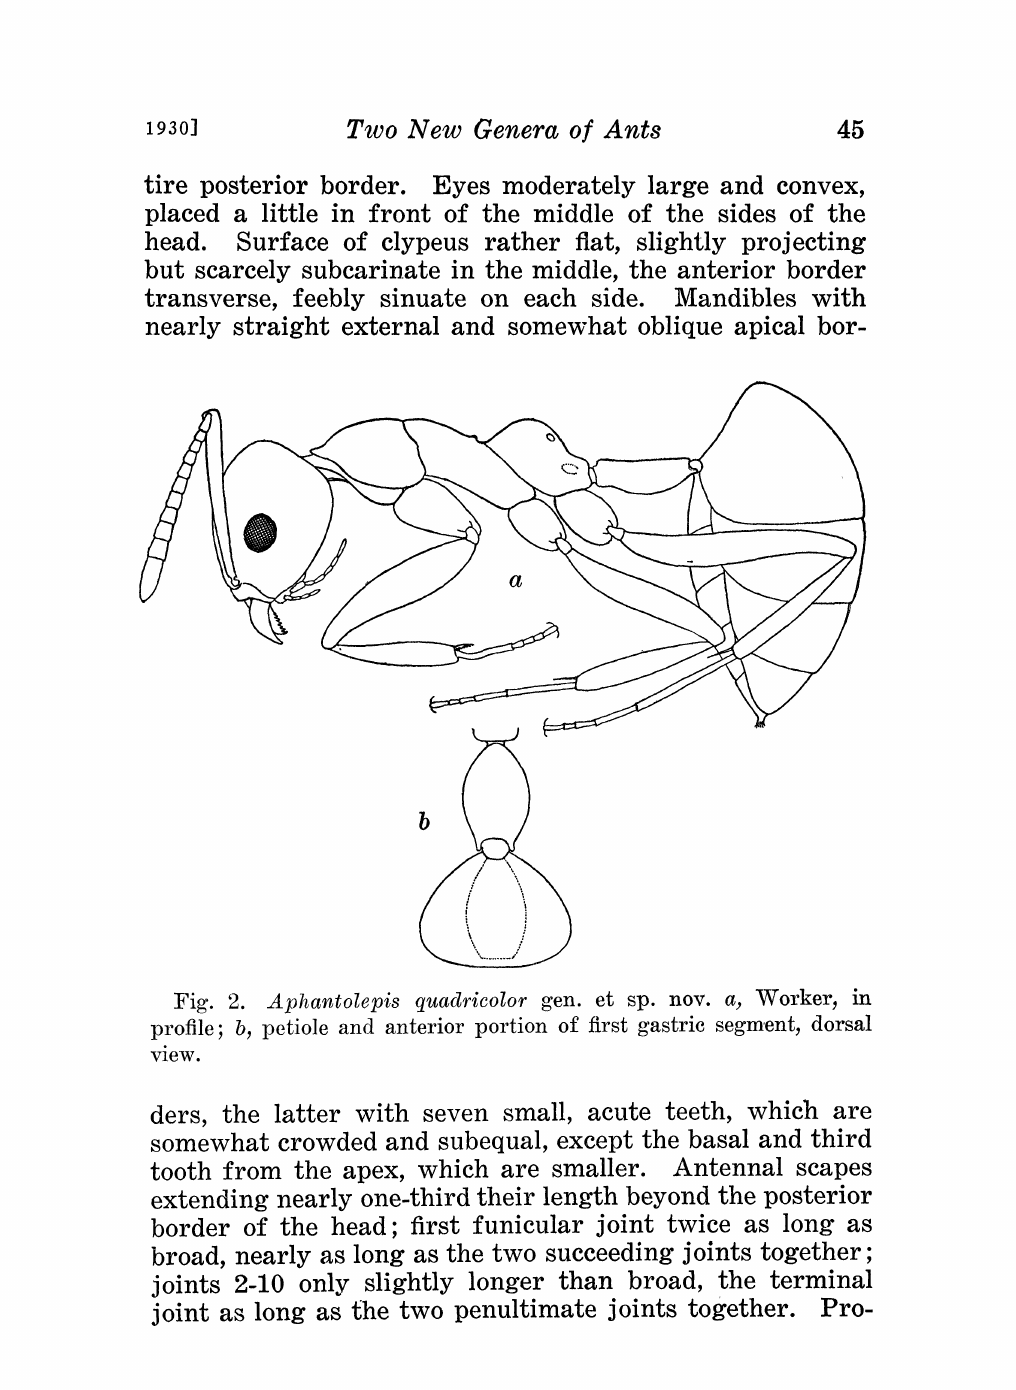
Fig. 2. Aphantolepis quadricolor gen. et sp. nov. a, Worker in profile; b, petiole and anterior portion of first gastric segment, dorsal